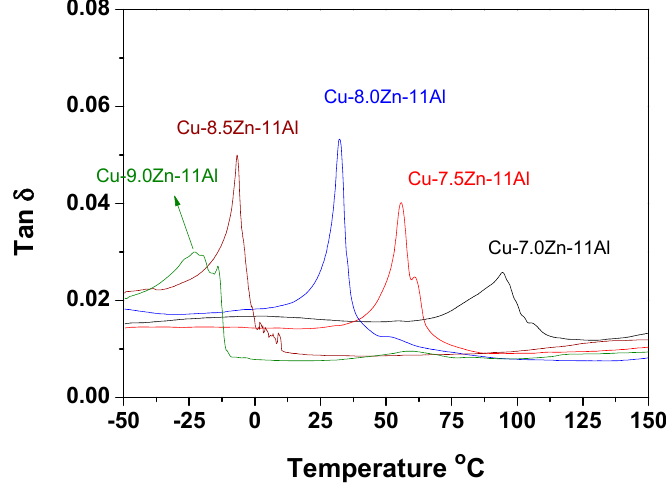
Figure 6. DMA tan δ curves measured at 10 Hz and 1 °C·min − 1 cooling rate for Cu-xZn-11Al SMAs with various Zn contents.